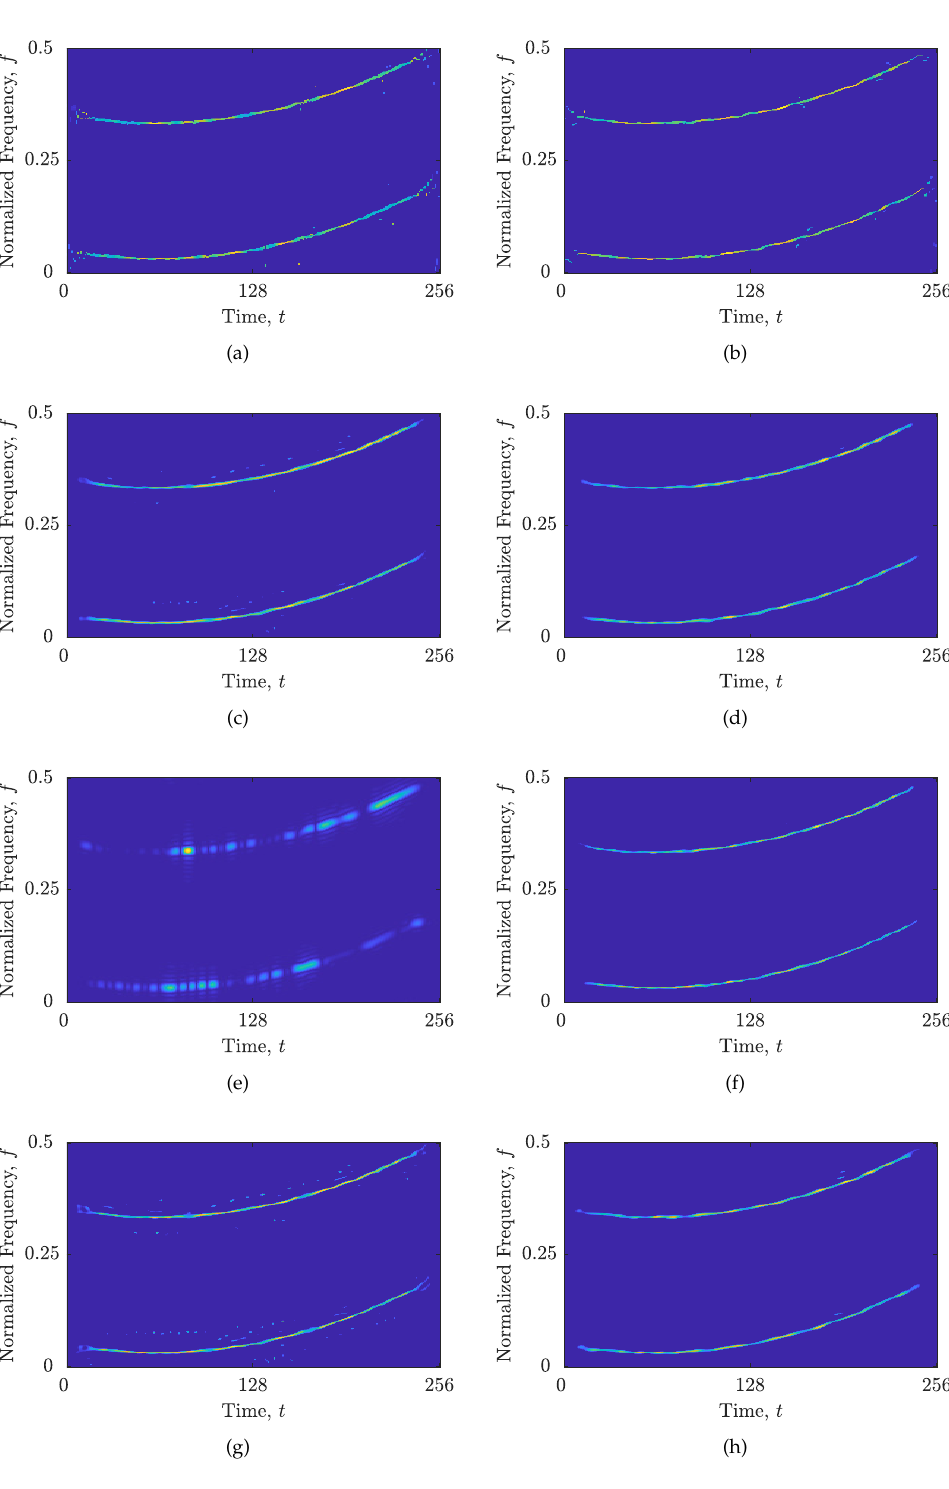
Figure 6. Reconstructed sparse TFDs of z SS with: ( a ) RTwIST algorithm, Γ = 0, Υ = 1; ( b ) RTwIST algo- rithm, Γ + = 0.046, Υ + = 0.426; ( c ) TwIST algorithm, Γ = 0, Υ = 1; ( d ) TwIST algorithm, Γ + = 0.043, Υ + = 0.520; ( e ) SpaRSA algorithm, Γ = 0, Υ = 1; ( f ) SpaRSA algorithm, Γ + = 0.029, Υ + = 0.515; ( g ) SALSA algorithm, Γ = 0, Υ = 1; ( h ) SALSA algorithm, Γ + = 0.070, Υ + =